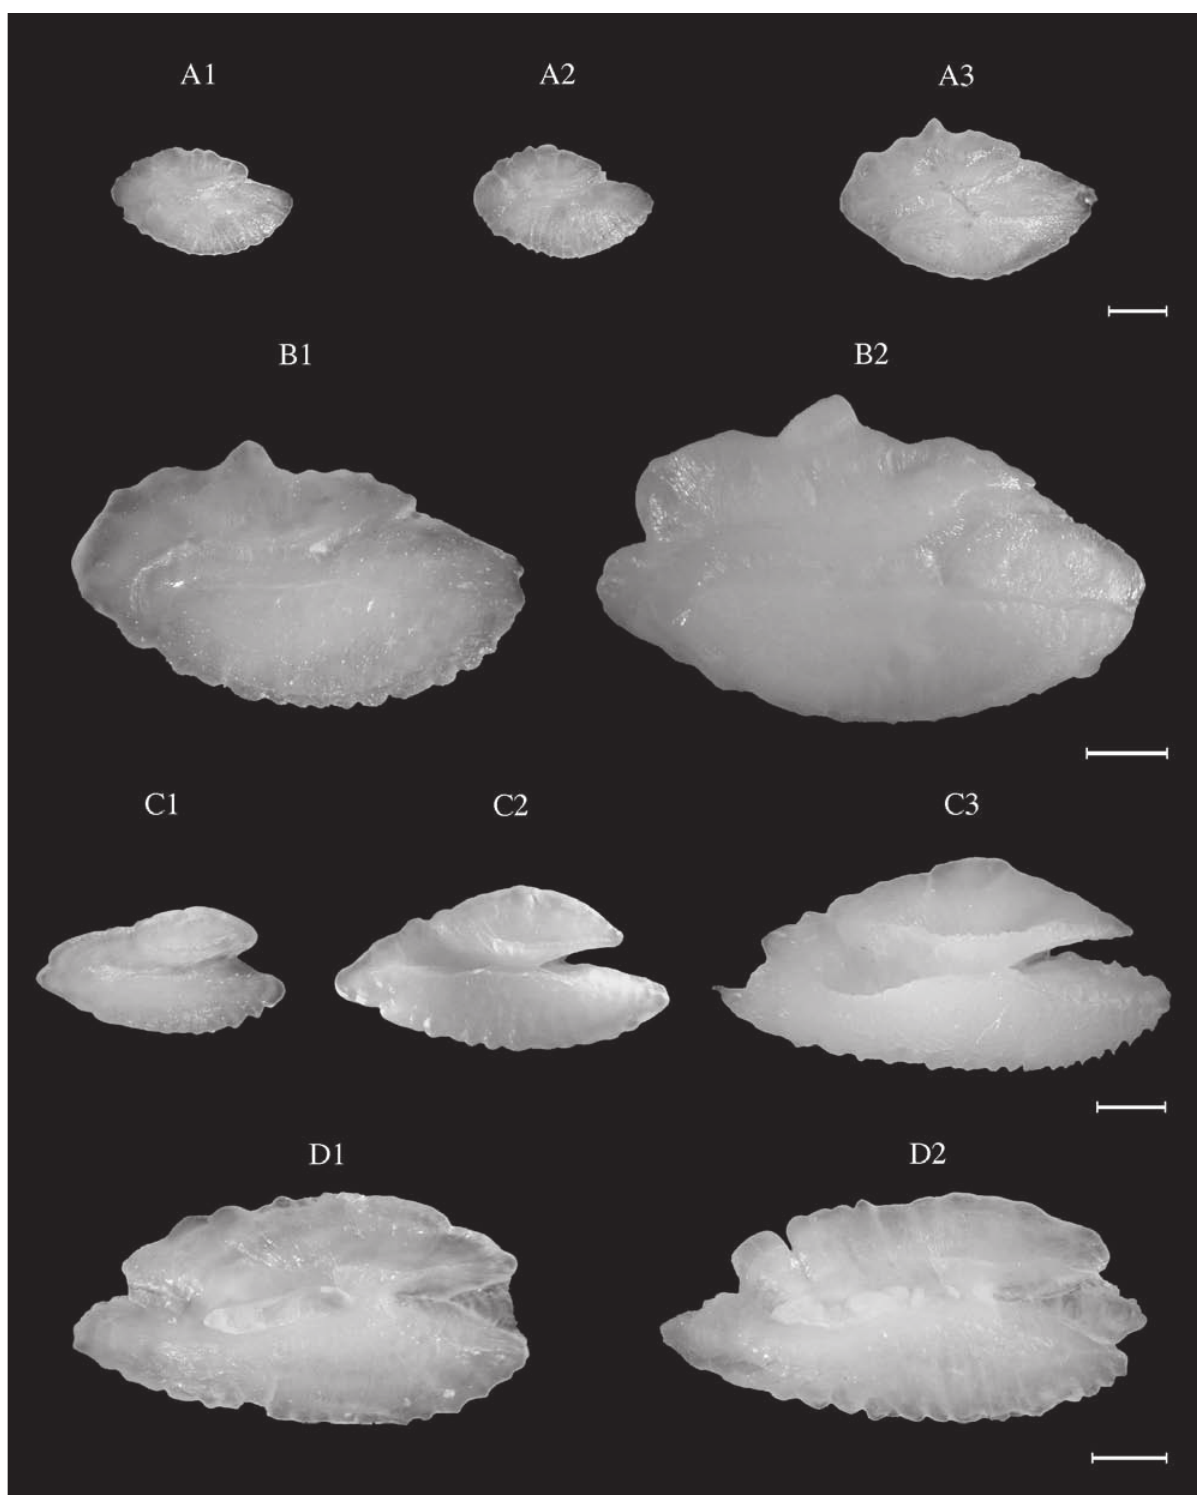
Fig. 67. – Chromis chromis (WM). TL: A1, 5.5 cm; A2, 6.5 cm; A3, 9.0 cm. Chromis limbata (CEA) . TL: B1, 11.6 cm; B2, 14.5 cm. Acantholabrus palloni . TL: C1, 12.5 cm (WM); C2, 20.8 cm (NEA); C3, 29.5 cm (CEA). Bodianus scrofa (CEA). TL: D1, 30.7cm; D2, 31.1 cm. Scale bar = 1